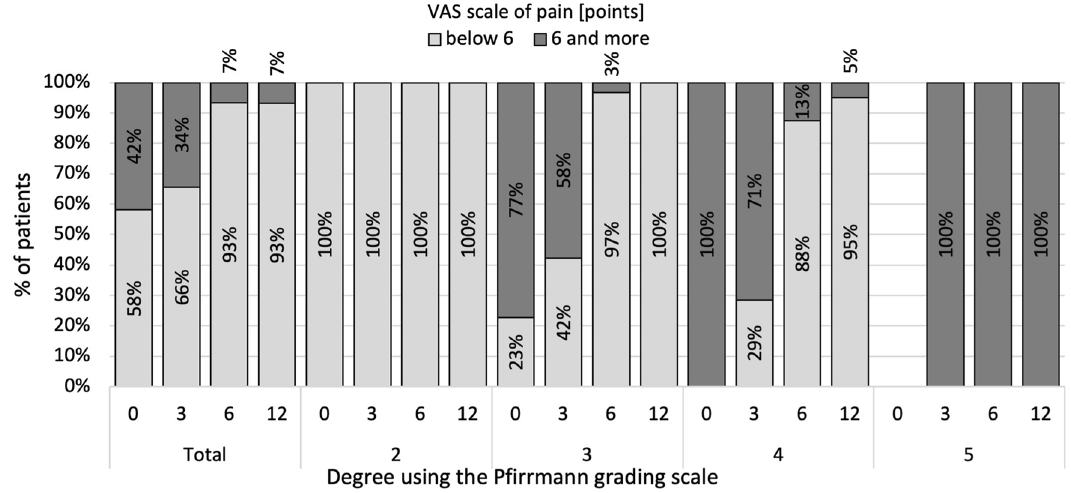
Figure 1. Percentage of patients in whom there was an improvement in quality of life in groups due to the radiological degree of advancement of degenerative changes according to the Pfirrmann scale, accounting for the pain